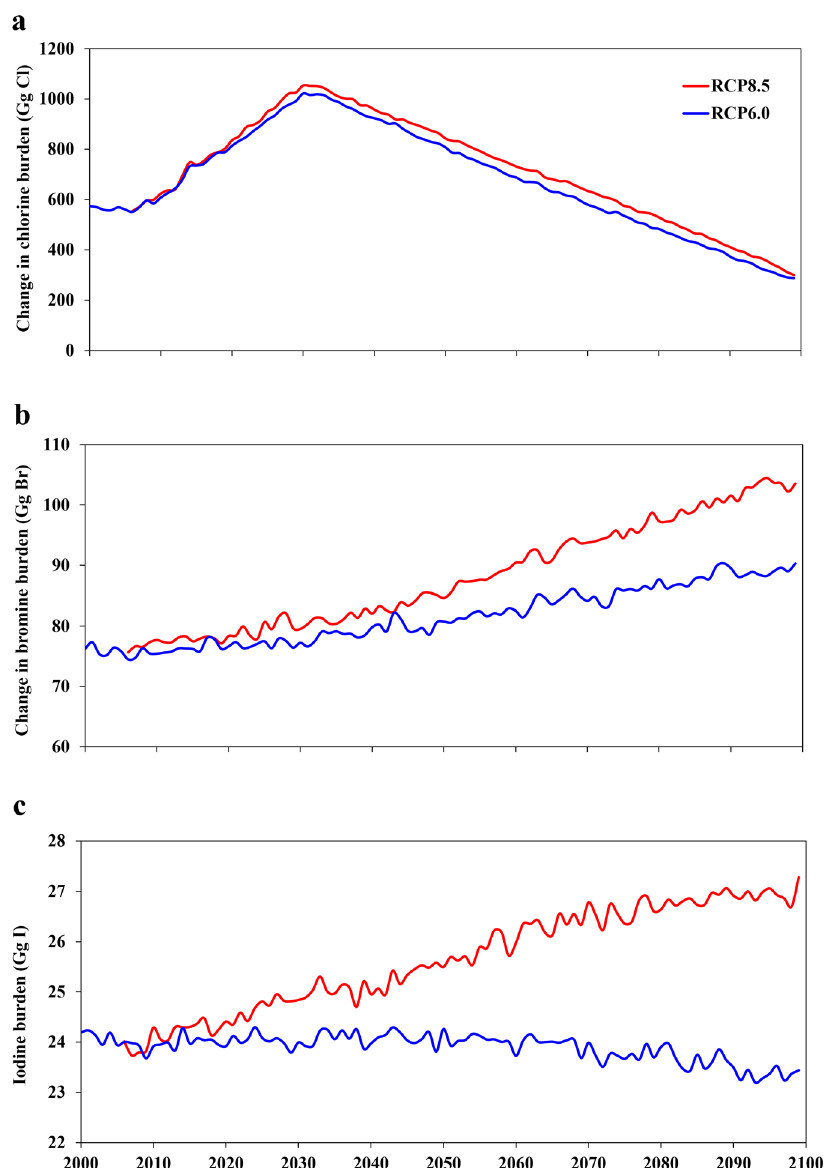
Fig. 1 Reactive halogen species burden in the troposphere in the 21st century for RCP6.0 (blue line) and RCP8.5 (red line) scenarios. a reactive chlorine species (Cl y ). b reactive bromine species (Br y ). c reactive iodine species (I y ). De fi nitions of Cl y , Br y , and I y are included in Methods. The case without RHS (noHAL) contains a small amount of chlorine and bromine (but no iodine) species in the troposphere resulting from the breakdown of long- lived halogens in the stratosphere and the subsequent transport to the troposphere; therefore, this fi gure shows the RHS-mediated changes in tropospheric chlorine and bromine burdens but it shows the absolute levels of iodine species. Note that the results for RCP8.5 are only shown from 2006 to 2100 and the results before 2006 are identical to those in